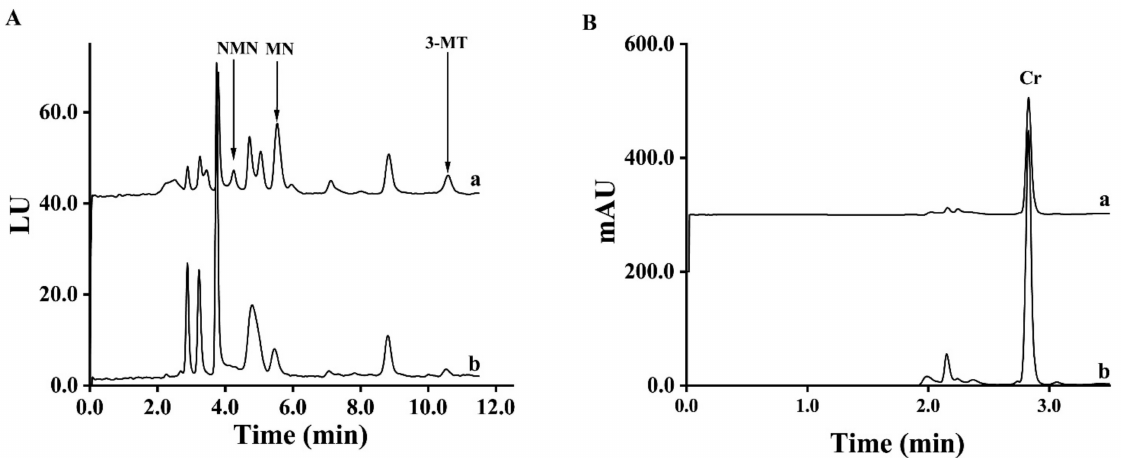
Figure 3. Chromatograms of spot urine samples from a PPGLs patient (a) and a healthy control (b) (( A ). FLD; ( B ).